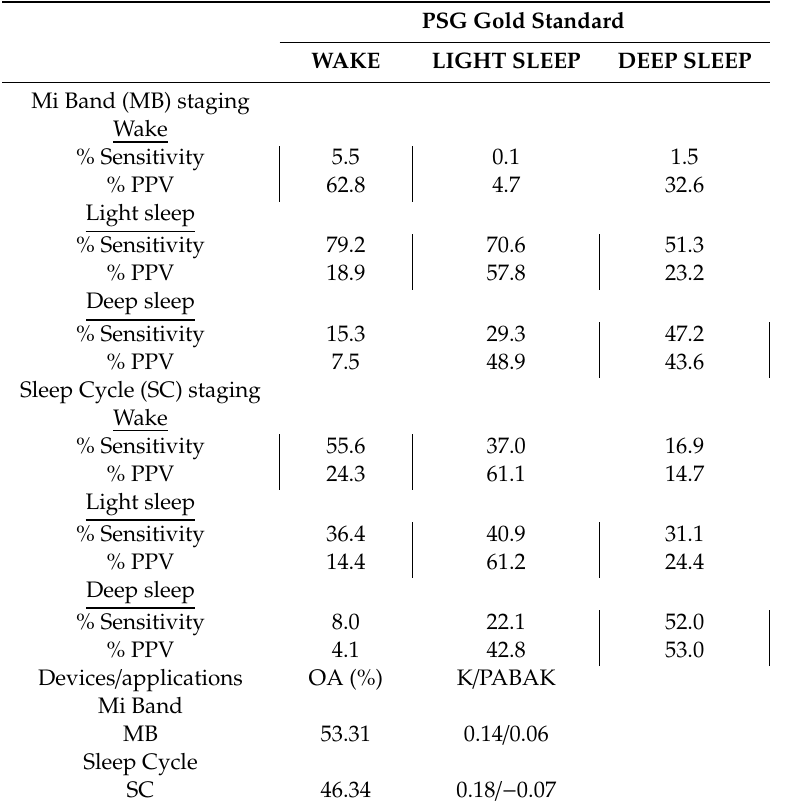
Table 1. Percentages of agreement for 3 stages of sleep scoring (awake / light sleep / deep sleep) between the gold standard (PSG) and the scoring of MB and